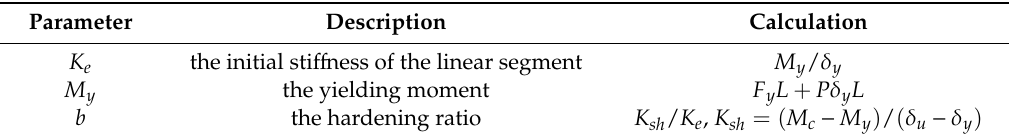
Table 2. Definition and determination of the bi-linear lumped plasticity (LP) model.